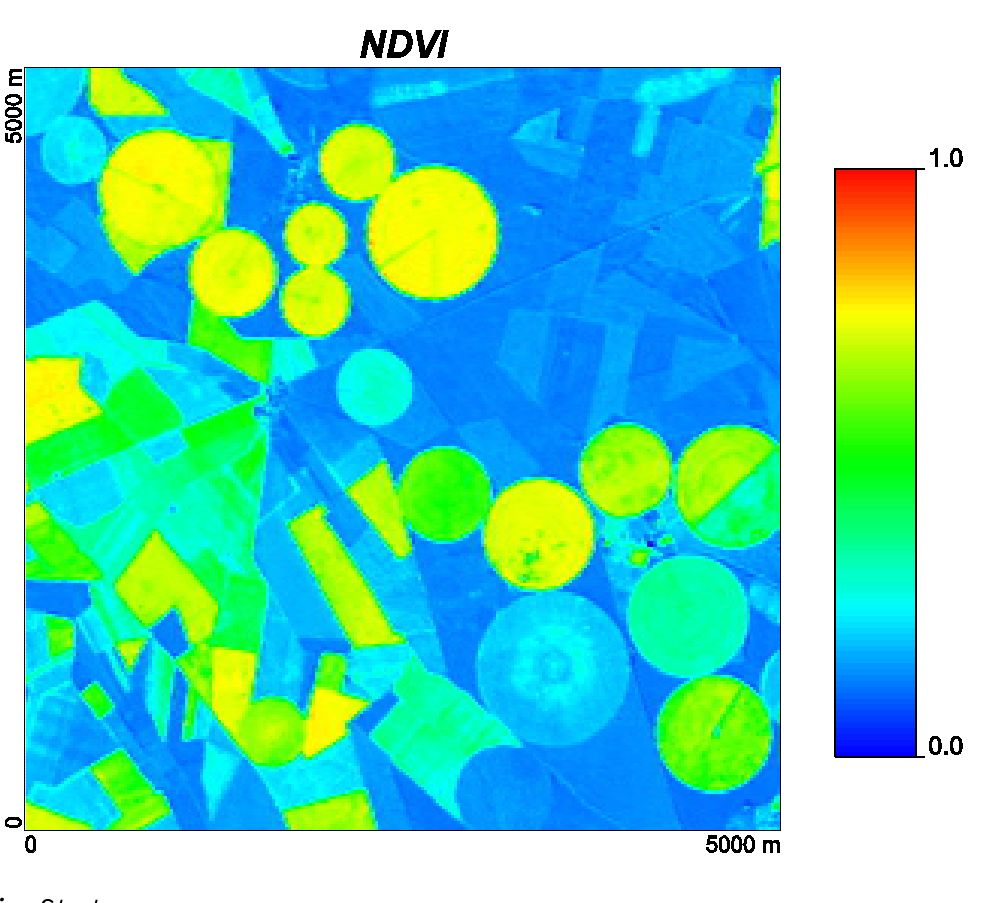
Figure 2. NDVI derived from the SPOT TOA reflectance data over the study